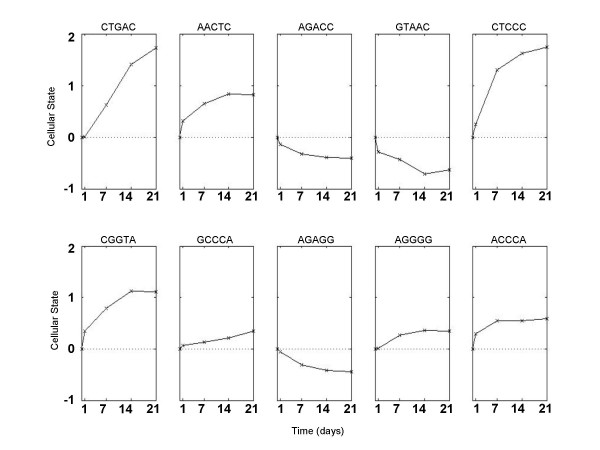
State transition of the predicted binding motifs. The predicted state levels are plotted on days 1, 7, 14, and 21 during in vitro chondrogenesis. The positive level indicates stimulation, and the negative level shows inhibition. The 5-bp DNA sequences, predicted with the ant algorithm, include CTGAC, AACTC, AGACC, GTAAC, CTCCC, CGGTA, GCCCA, AGAGG, AGGGG, and ACCCA.